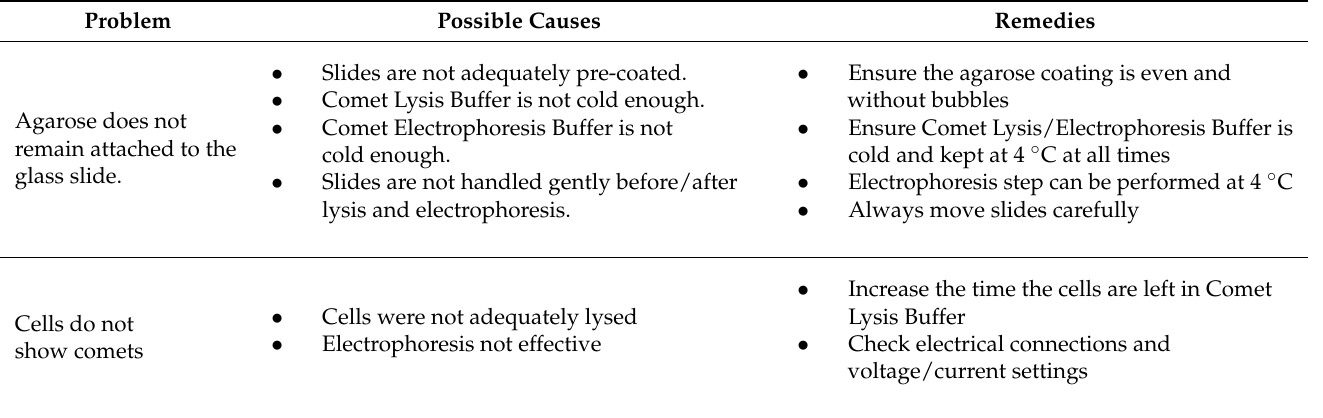
Table 1. Cause and